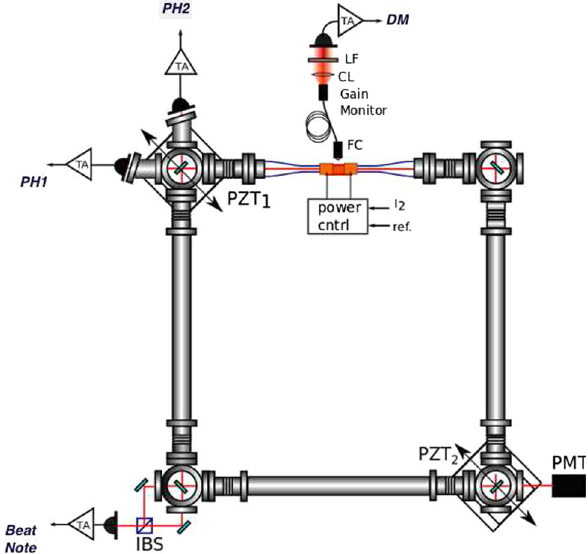
Fig. 1 Typical scheme of RLG with a square ring